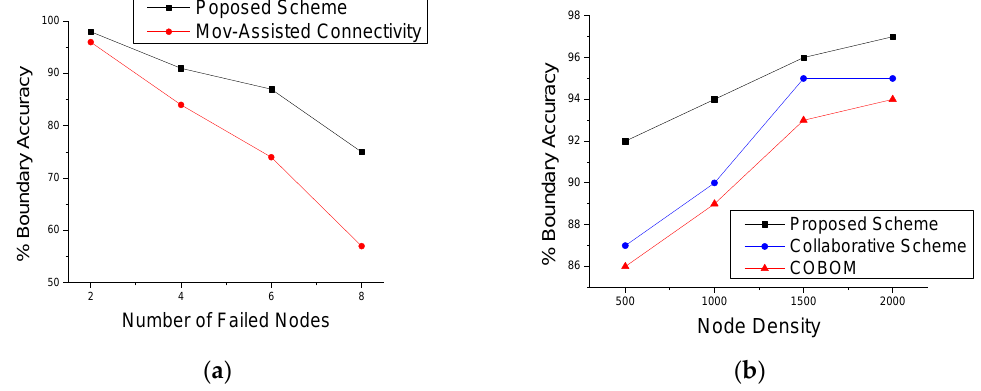
Figure 11. Boundary accuracy against different ( a ) numbers of node failures and ( b ) network densities.